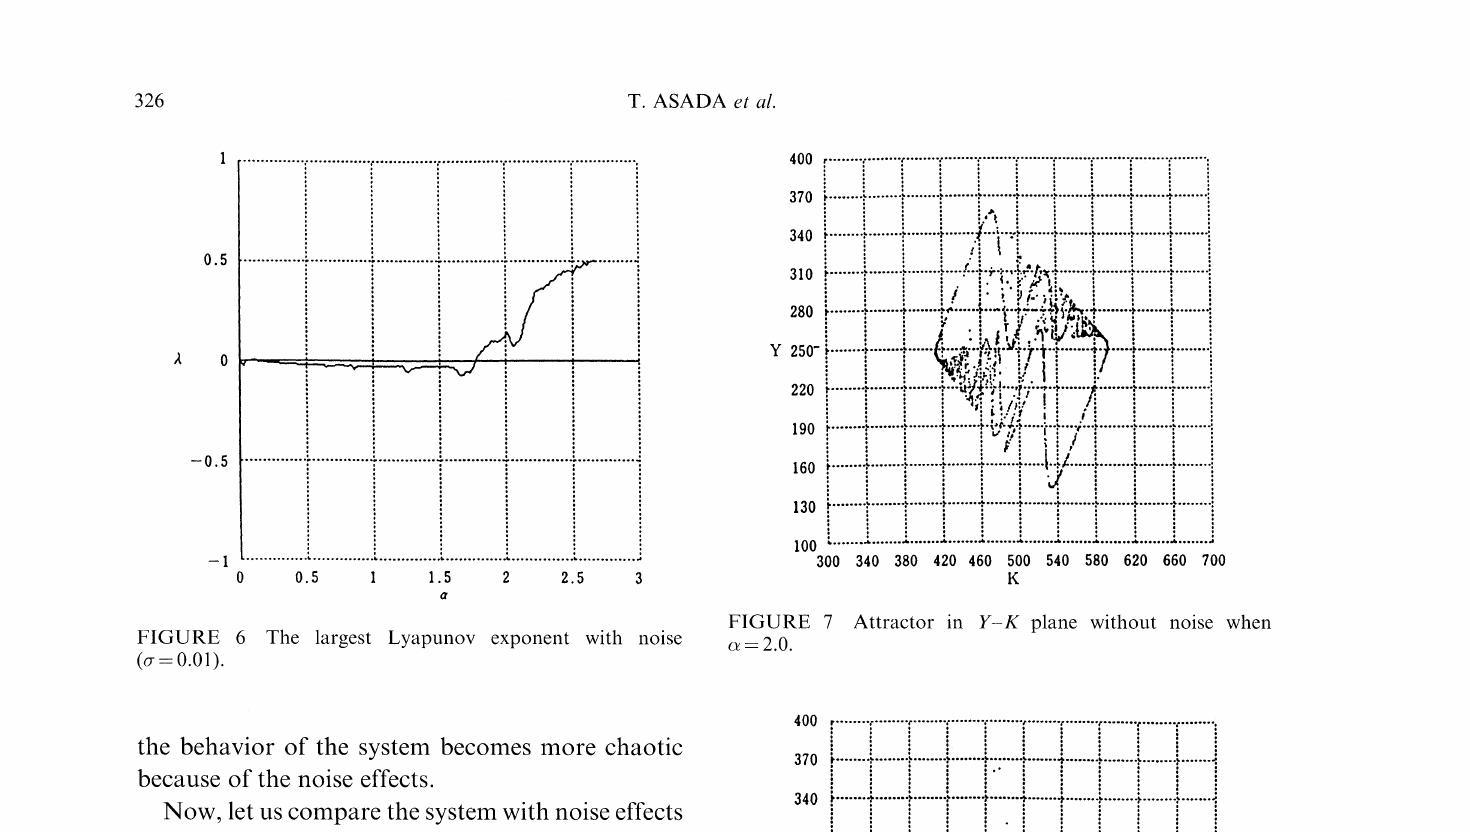
FIGURE 7 Attractor in Y-K plane without noise when c 2.0.